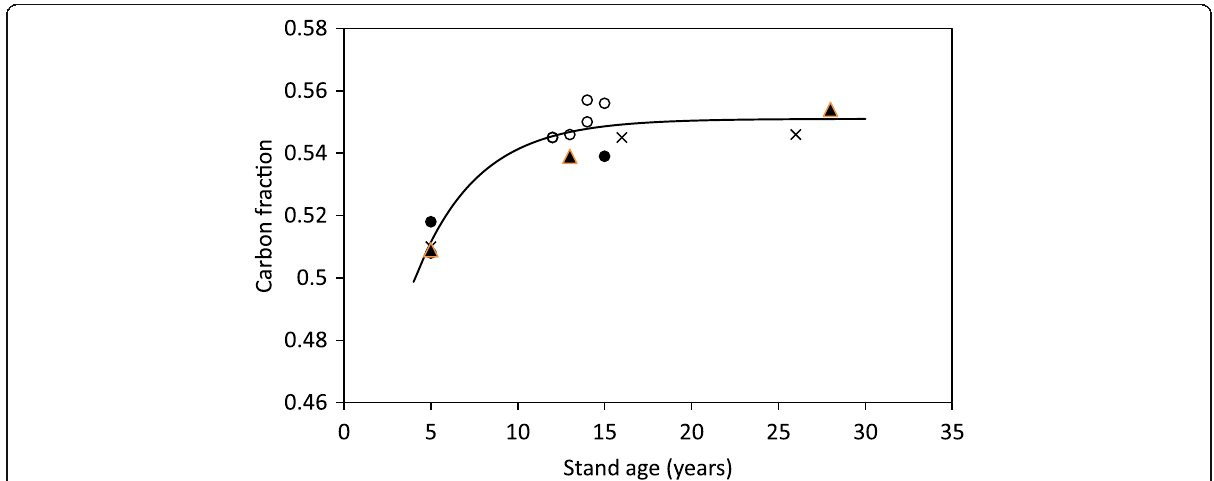
Fig. 1 Carbon fraction of stem bark as a function of stand age in New Zealand radiata pine biomass studies. Three sites were sampled at multiple ages: Woodhill (triangles), Kinleith (dots) and Tarawera (crosses). The remaining eight sites were sampled only at one age (circles). The line shows the fitted exponential function: CF stembark = 0.551 × (1 − 0.291 × exp( − 0.280 ×